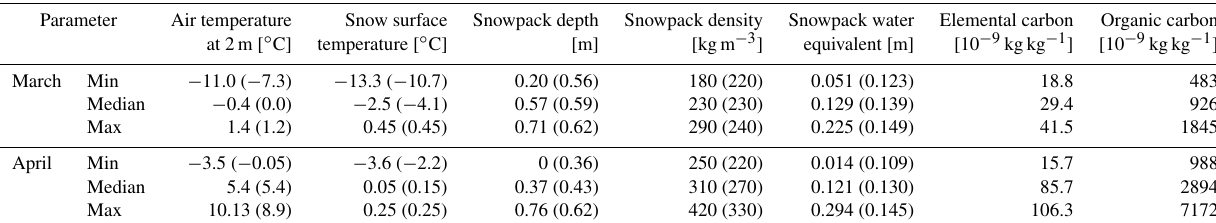
Table 1. The variation range and median values of the air temperature and snow surface temperature during the SNORTEX campaign in Sodankylä in 11–19 March and 20–27 April 2009. The corresponding variation of the snow density and snow water equivalent are given as well. The measurements were carried out during 09:00 and 17:00h local time (Manninen and Roujean, 2014). The values in brackets are those measured at the reference site NorSEN mast (67.3621 ◦ N, 26.63445 ◦ E) in Tähtelä. The total number of individual measurements was altogether 118 (17) for the reference site. The elemental carbon and organic carbon concentrations measured near the NorSEN mast (67.364011 ◦ N, 26.635891 ◦ E) in March and April are shown as well (Meinander et al.,